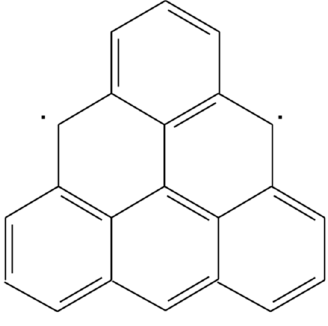
Figure 2. Non-Kekulé triangulene diradical system. Figure 2. Non-Kekul é triangulene diradical